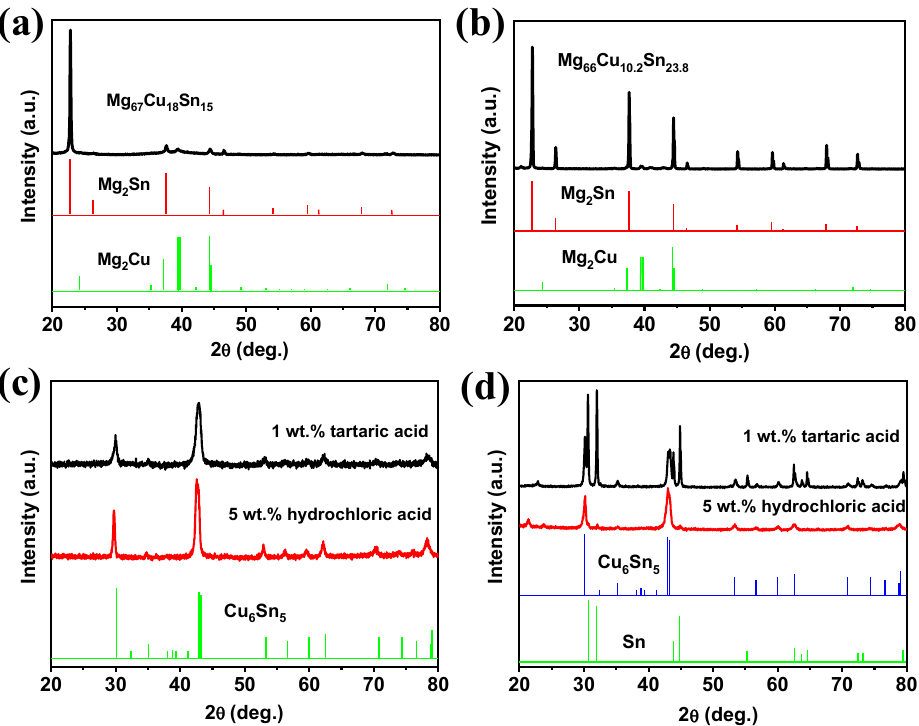
Figure 1. XRD patterns of ( a ) Mg 67 Cu 18 Sn 15 and ( b ) Mg 66 Cu 10.2 Sn 23.8 precursors; ( c ) dealloyed Cu 6 Sn 5 and ( d ) dealloyed Cu 6 Sn 5 /Sn composite. Reproduced from Ref. [28] with permission from the Royal Society of Chemistry.